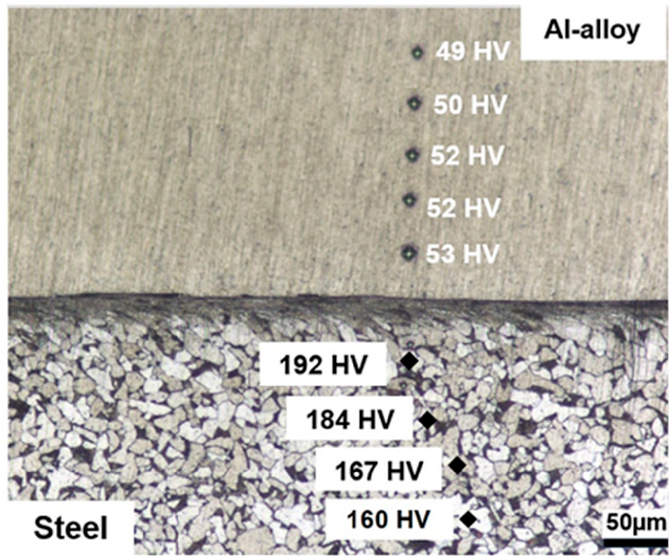
Figure 3. OM cross-section analysis of the as-deposited coating (Nital 2% etch) revealing homogenous hardness in the coating and hardening on the substrate side of the interface due to plastic deformation during the deposition process.